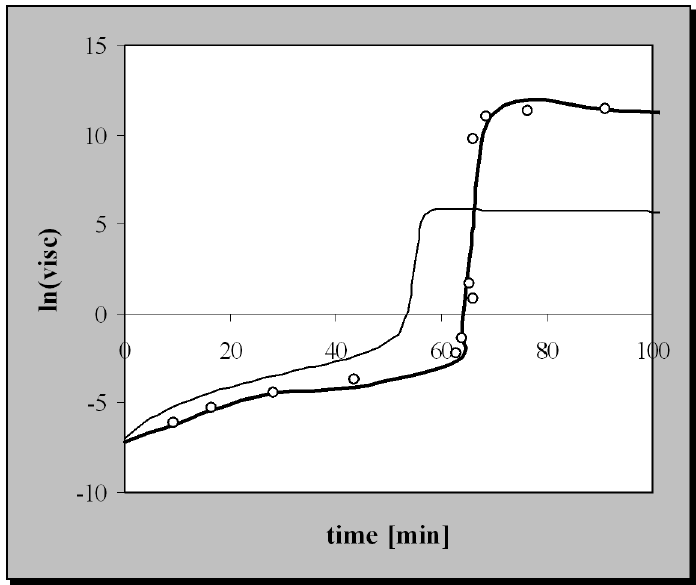
Fig. 14 Mass reaction viscosity obtained with MLP (3:12:4:1) (thick line), with Lyons - Tobolsky equation using kinetic model (thin line) and experimentally (o) [17] at 70 o C and 25.8 mol/m 3 .